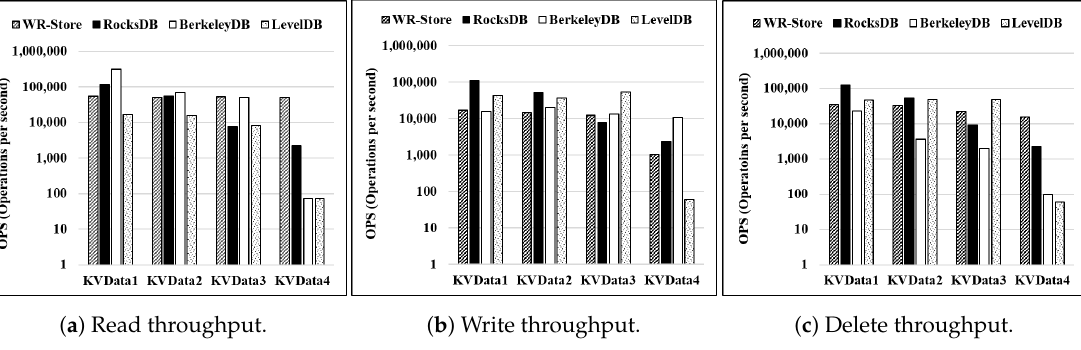
Figure 10. Throughput as the size of data set is increased. ( a ) Read throughput; ( b ) Write throughput; ( c ) Delete